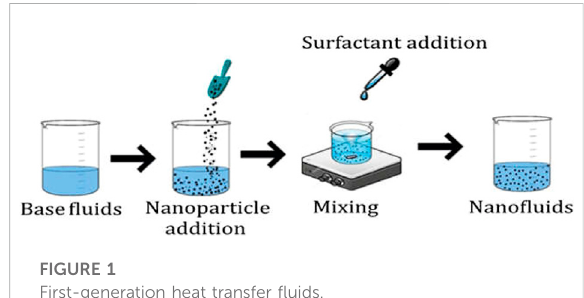
FIGURE 1 First-generation heat transfer fl